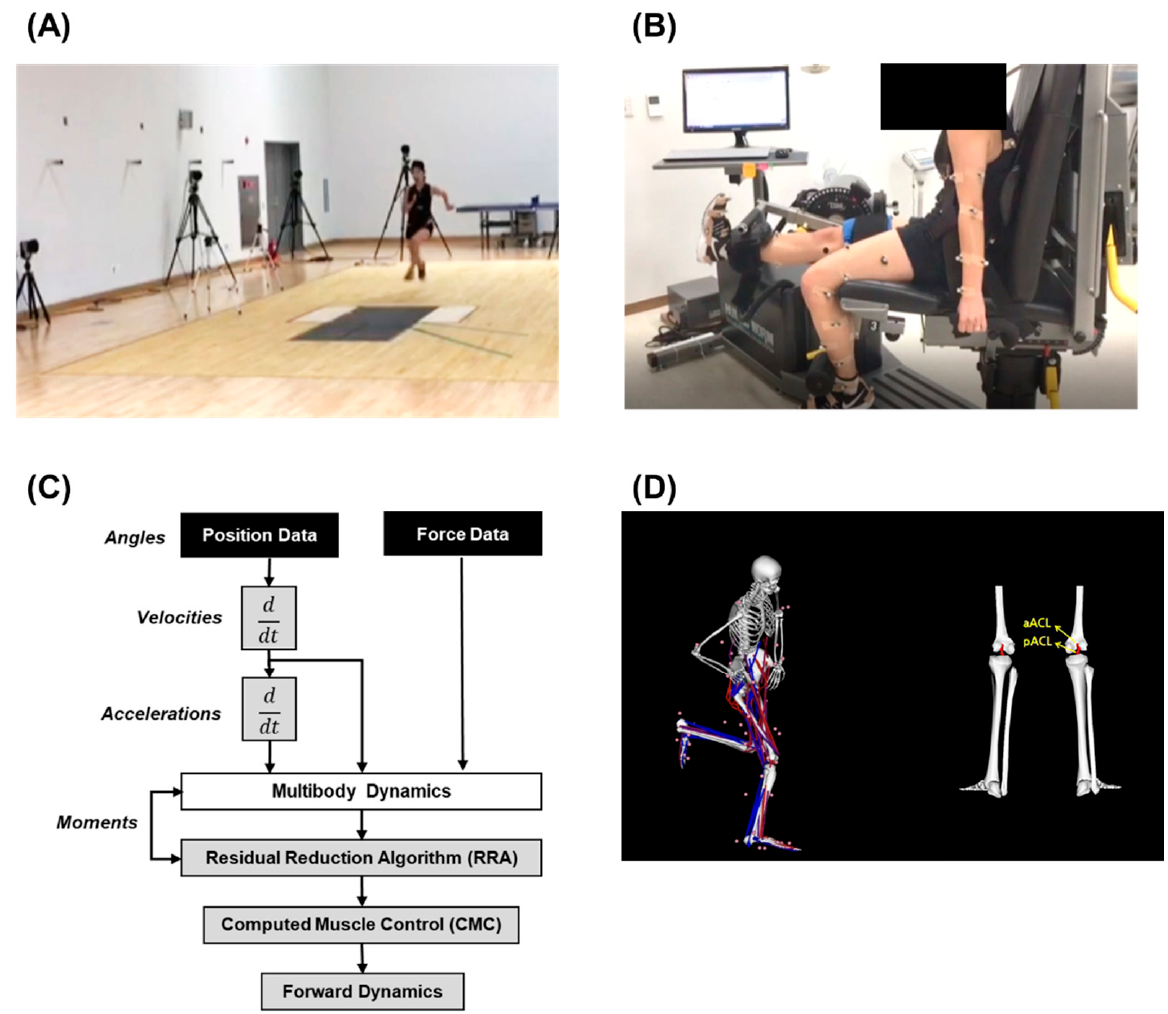
Figure 2. Experimental procedure. ( A ) Participants performing a direction diversion maneuver (DDM); ( B ) strength testing and fatigue treatment using an isokinetic dynamometer; ( C ) the process of calculating ACL load using a musculoskeletal modeling approach (MSM); ( D ) the MSM model used for the study. The open-source model provided in OpenSim (Stanford University, Stanford, CA, USA); two-bundle Anterior Cruciate Ligament (ACL) inserted between the femur and tibia (sagittal view).